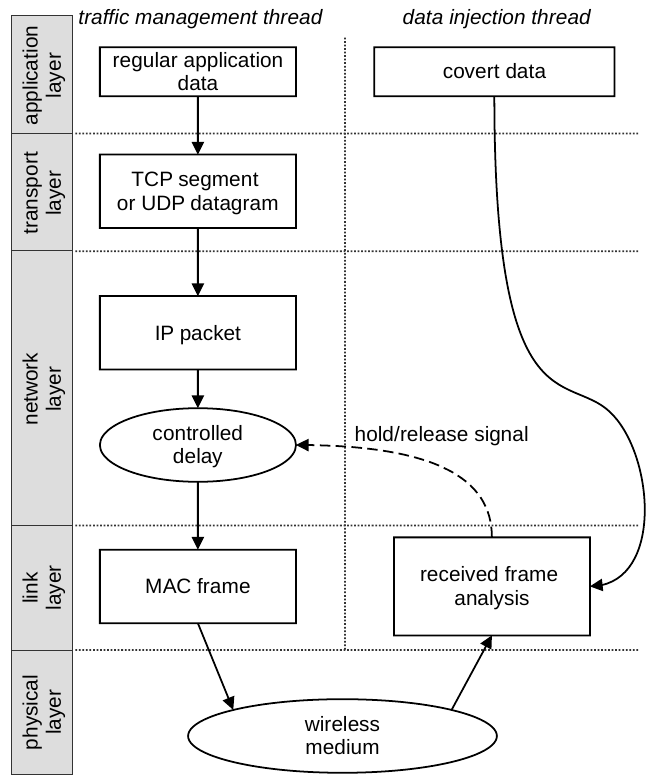
Figure 7. Multithreaded application for covert transmission control working